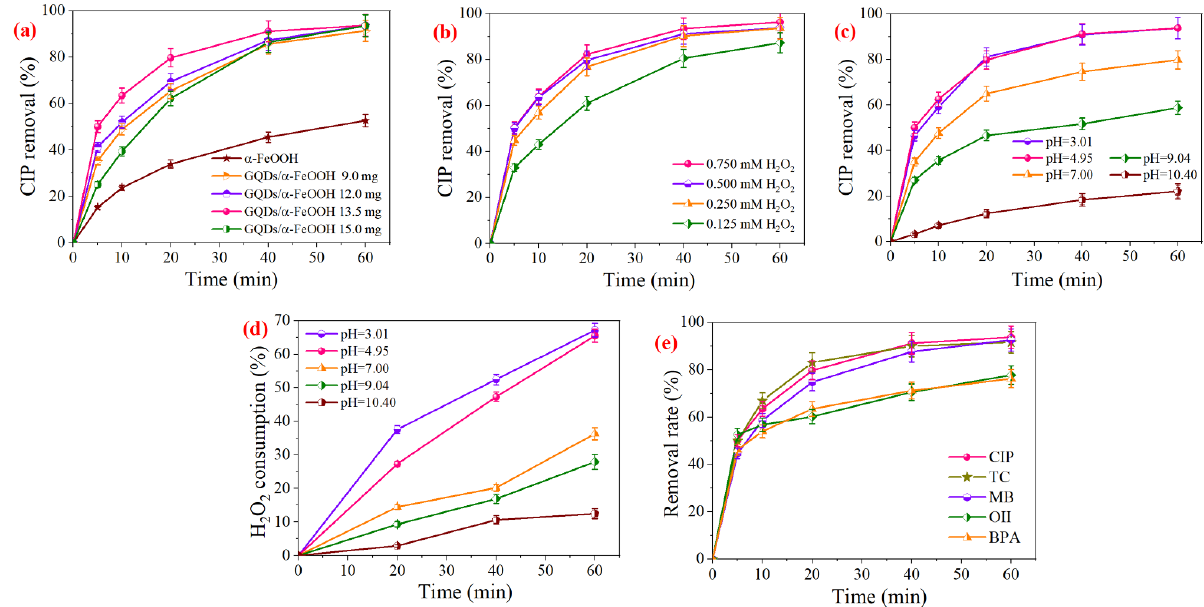
Figure 3. Influence of GQDs doping dosage ( a ); H 2 O 2 concentration ( b ); initial pH values ( c ); changes